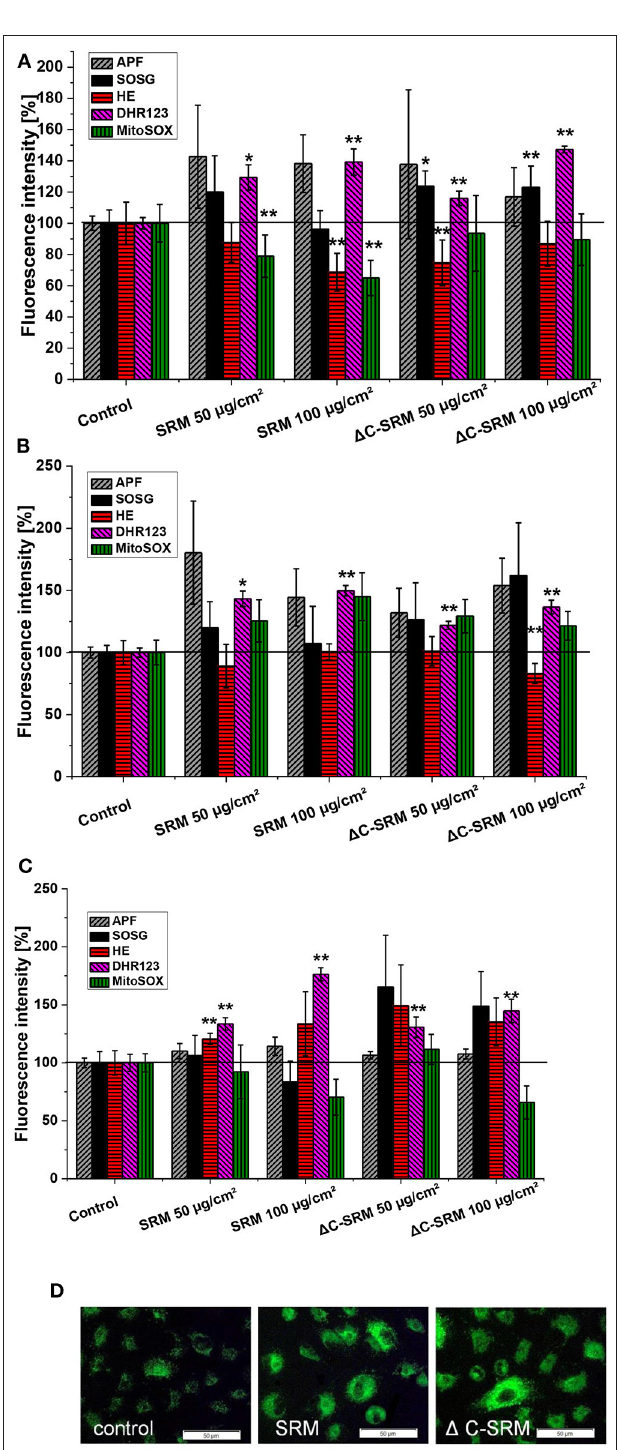
FIGURE 4 | The level of reactive oxygen species (ROS), measured by selective fluorescent probes, induced in A549 cells after their 24-h incubation on particulate matter (PM)-covered plates either uncoated (A) or coated with collagen (B) and fibronectin (C) (exposure method 2). SOSG, Singlet Oxygen Sensor Green ( 1 O 2 ); APF, aminophenyl fluorescein ( · OH, ONOO − , HOCl); DhR123, dihydrorhodamine 123 (H 2 O 2 , ONOO − , HOCl, cytochrome c); HE,